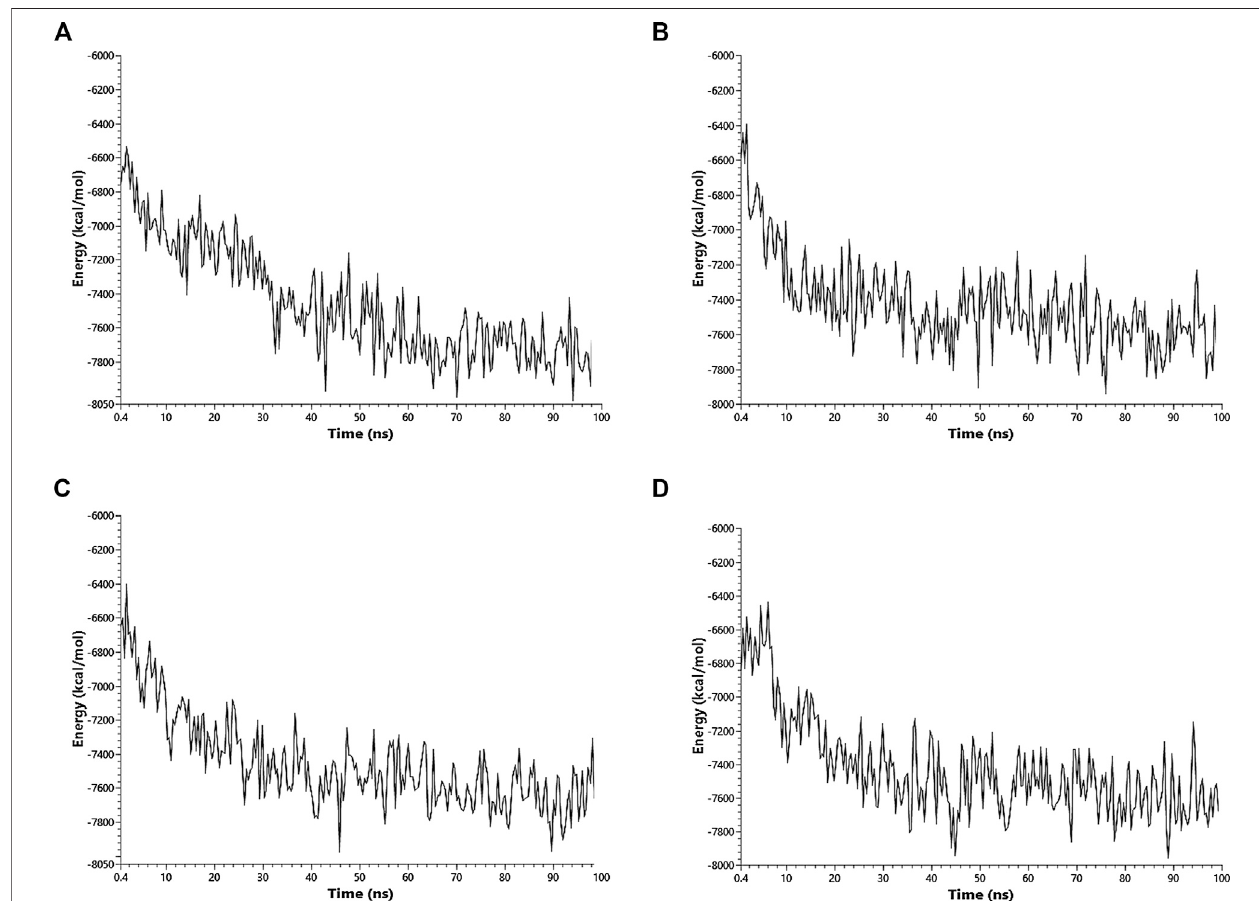
FIGURE 3 | Fluctuation of the thermodynamic stability of the RBD-ACE2 complex in the presence of Ibuprofen_CID_3672 (A) , Aspirin_CID_2244 (B) , Acetaminophen_CID_1983 (C) and the RBD-ACE2 protein complex without ligands (D) was used as a control. Everything was simulated to 100 ns